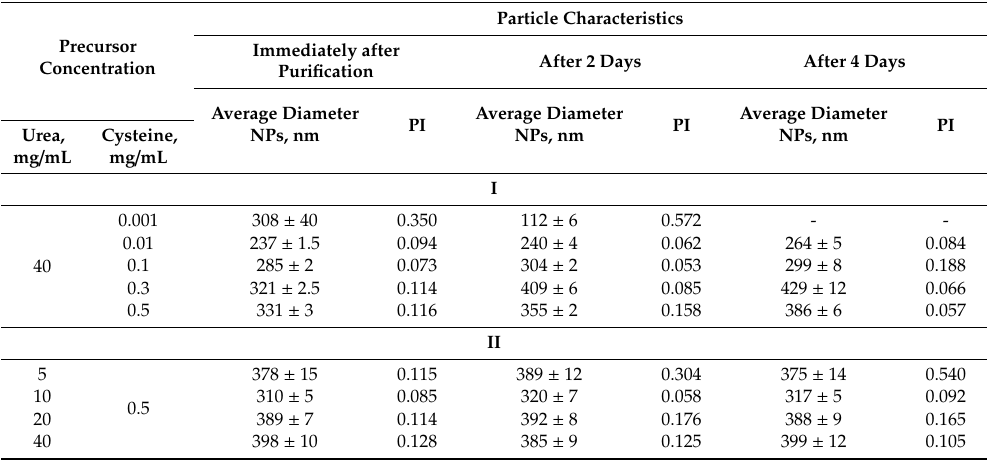
Table 1. The e ff ect of cysteine concentration on the physico-chemical characteristics of empty albumin NPs: [HSA] = 10 mg / mL, T = 25 ◦ C. Particle Characteristics